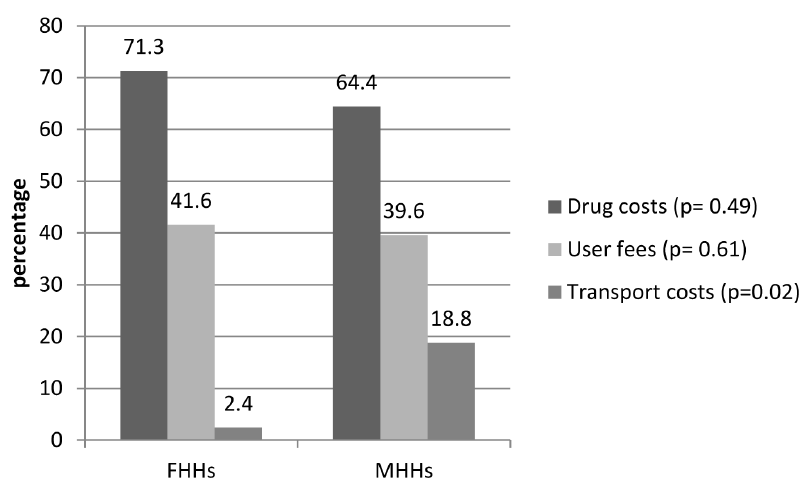
Figure 3. Affordability reasons for not seeking care. doi:10.1371/journal.pone.0093887.g003 PLOS ONE |